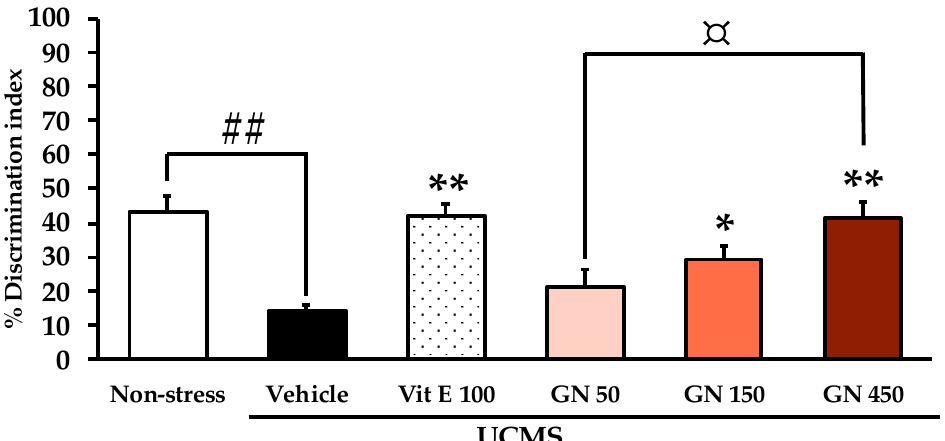
Figure 3. The effect of the GN bark resin extract on learning and memory in the NORT. Each column represents the mean ± SEM ( n = 10–11). ## p < 0.001 vs. the vehicle-treated non-stress group. * p < 0.05, ** p < 0.001 vs. the vehicle-treated UCMS group and ¤ p < 0.05 vs. the GN bark resin extract (Post-hoc Tukey test).